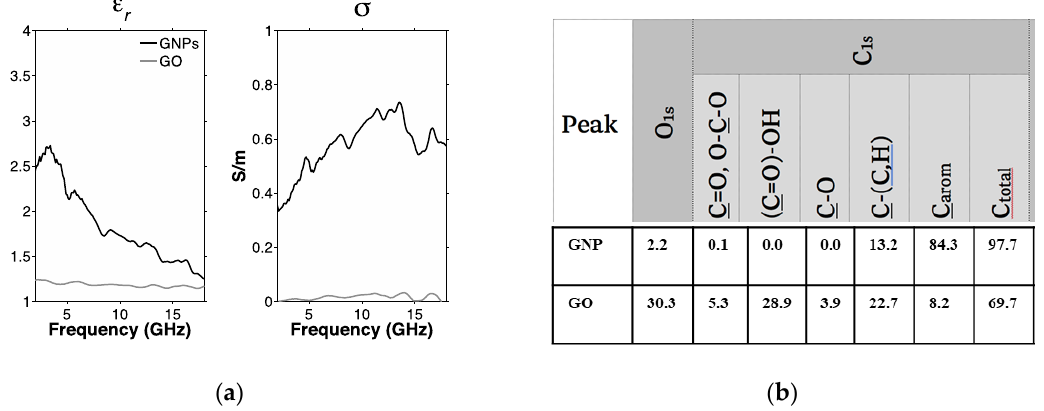
Figure 10. ( a ) Comparison of electrical parameters ε r and σ for GNPs and GO; ( b ) XPS analysis confirming the higher oxygen content in GO, responsible for lower σ